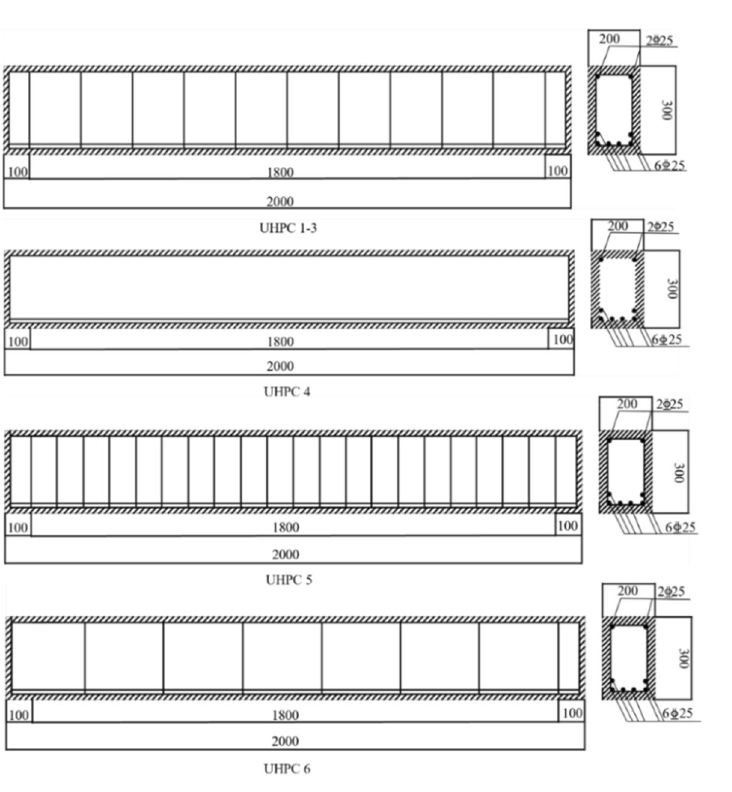
Figure 1. UHPC beam reinforcement diagram.